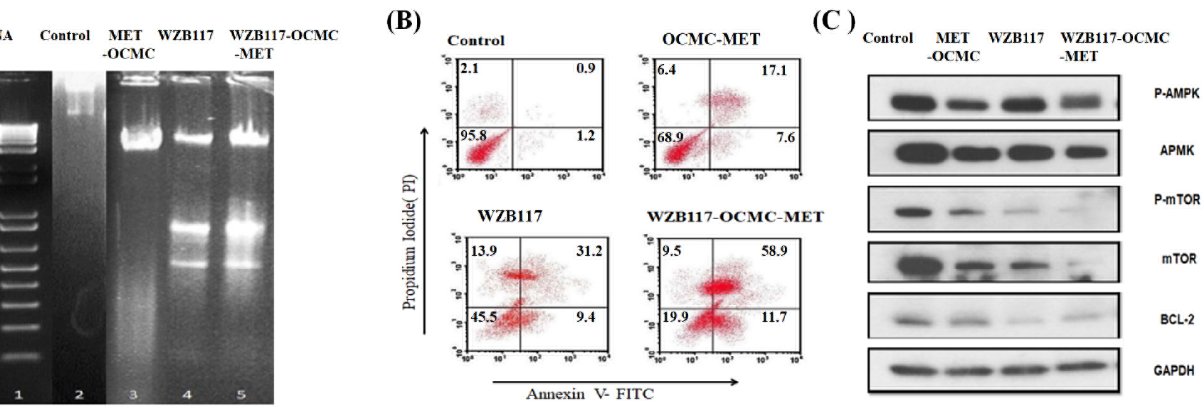
Figure 5. ( A ) DNA fragmentation of the MDA-MB-231 cell line using the MET-OCMC, WZB117, and WZB117-OCMC-MET. ( B ) Quantitative measurement of apoptosis by AnnexinV-FITC versus PI in MDA-MB-231 cells treated with OCMC-MET, WZB117, and WZB117-OCMC-MET. The data clearly indicate high late-phase apoptosis for the WZB117-OCMC-MET compared to OCMC-MET . ( C ) mTOR and BCL2 mediated apoptosis induced by WZB117-OCMC-MET compared with OCMC-MET. The OCMC-MET only downregulates the mTOR but does not alter the BCL2, whereas WZB117-OCMC-MET synergistically targets mTOR and BCL2. ( D ) Cellular internaliza- tion of WZB117-OCMC-MET and OCMC-MET in the MDA-MB-231 cancer cell line indicates that the complex was more effective in inter-cellular penetration due to the presence of WZB117 con- jugation (50 µm scale bar). ( E ) Percentage population of the cancer cells and flow cytometric anal- ysis at a different phase of the cell cycle. 3.7. Apoptosis Assay to Evaluate the Efficacy of Conjugate Nanoparticles by Flow Cytometry The Annexin V-FITC/PI double labeling was applied to quantify the polymeric Nps apoptotic effect on the MDA-MB-231 cancer cell line (Figure 5B). The fluorescent dye, PI, entered necrotic cells but not living cells. Detecting apoptosis phase cells using different staining patterns: viable (Annexin V− and PI−, lower left square), early apoptotic (An- nexin V+ and PI−, lower right square), late apoptotic (Annexin V+ and PI+, upper right square), and necrotic (Annexin V− and PI+, upper left square) [53]. Figure 5B showed that the use of WZB117 and WZB117-OCMC-MET enhanced the number of late apoptotic cells compared to OCMC-MET. The control group had 1.2% early and 0.9% late apoptotic cells, whereas the WZB117-OCMC-MET group had 11.7% and 58.9%. WZB117 had 9.4% and 31.2%, and OCMC-MET had 7.6% and 17.1% of early and late apoptosis, respective- ly. Inhibition of mTOR by OCMC-MET causes late-stage apoptosis. In the case of the WZB117-OCMC-MET, it suppresses both BCL2 and mTOR due to the presence of WZB117 and MET. The combination of both MET and WZB117 exhibits synergistically increased late-stage apoptosis owing to glycolysis and oxidative energy stress suppres- sion when compared to OCMC-MET alone. WZB117 was also found to be effective in producing apoptosis.